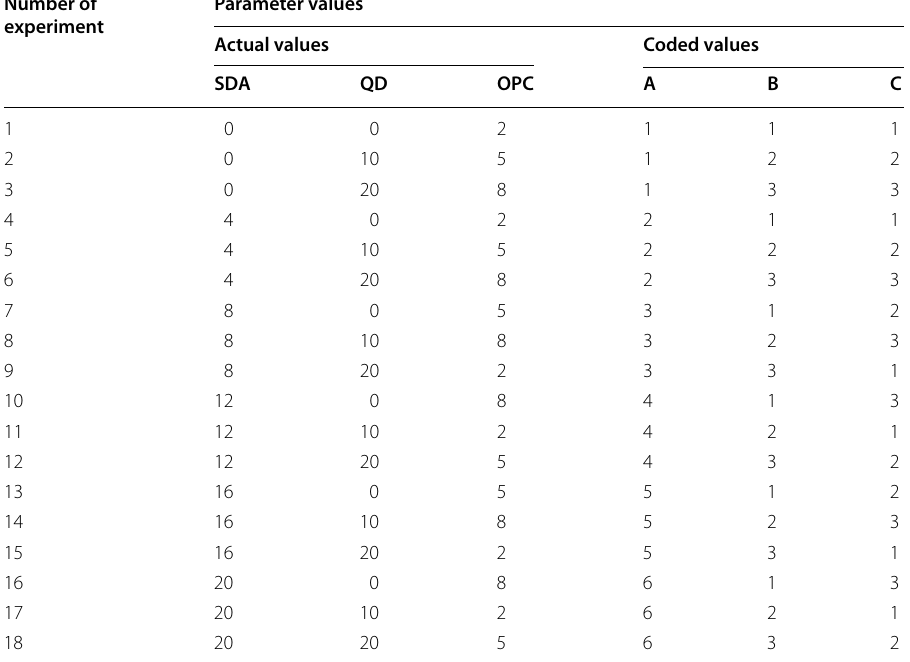
Table 4 Layout of Taguchi mixed level orthogonal array Number of